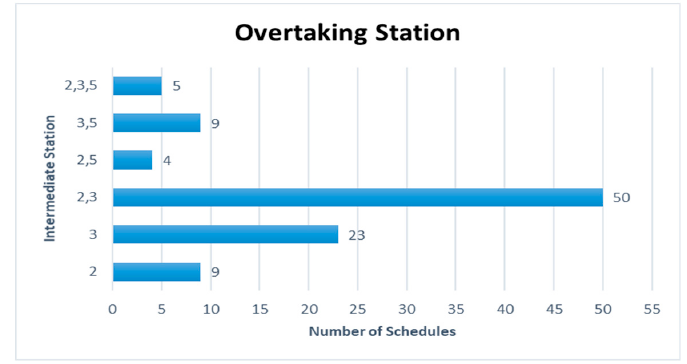
Figure 9. Overtaking Station for Case 1.